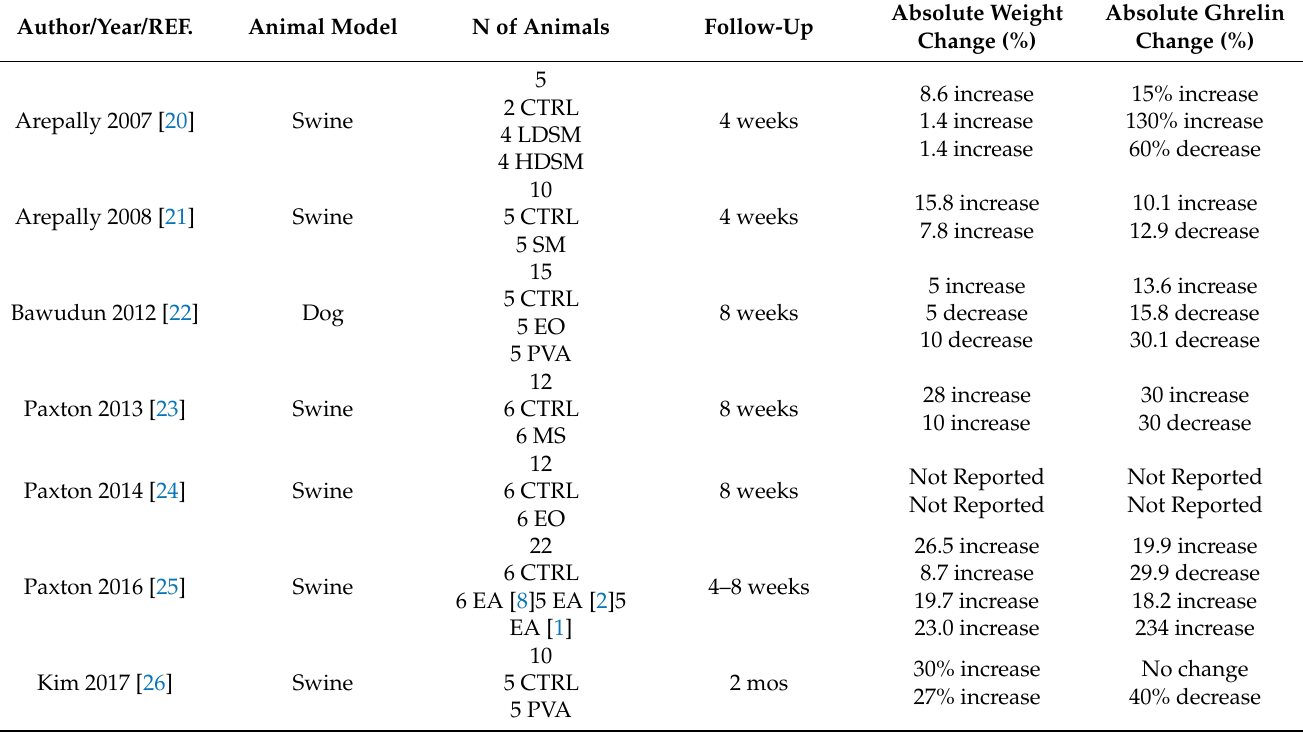
Table 1. Experimental studies evaluating BES procedure for weight